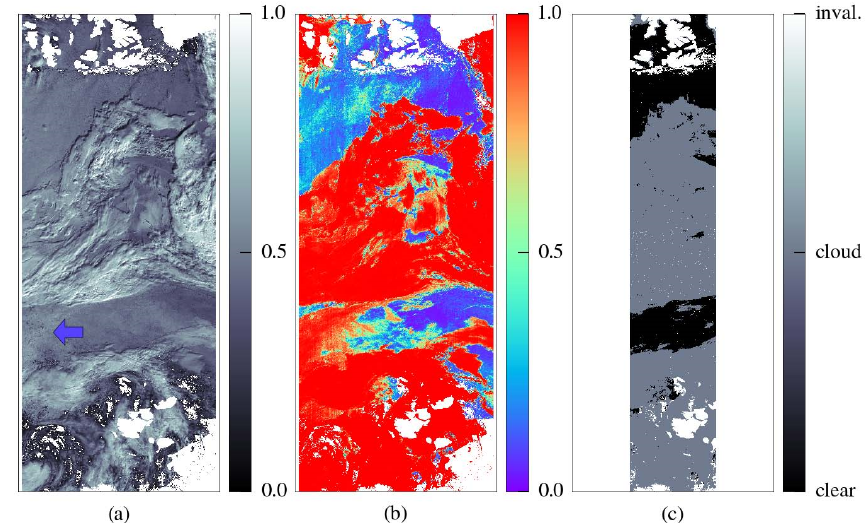
Figure 4. Reflectance at 779nm (a) , cloud probability (b) and corresponding AATSR mask (c) for 31 July 2009 (orbit number 38778). The blue arrow marks a region with wrongly screened-out clear-sky pixels, although a thin cloud cover is